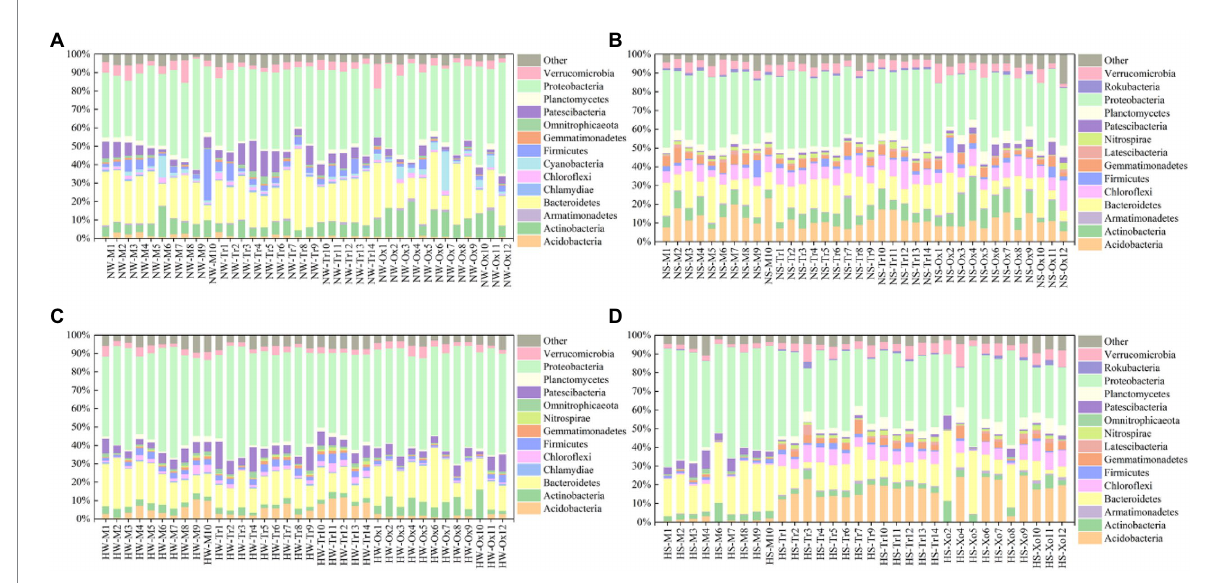
FIGURE 2 Relative abundances of major bacterial phyla in water and sediment samples of different periods. (A) Water in the normal period. (B) Sediment in the normal period. (C) Water in the high-water period. (D) Sediment in the high-water